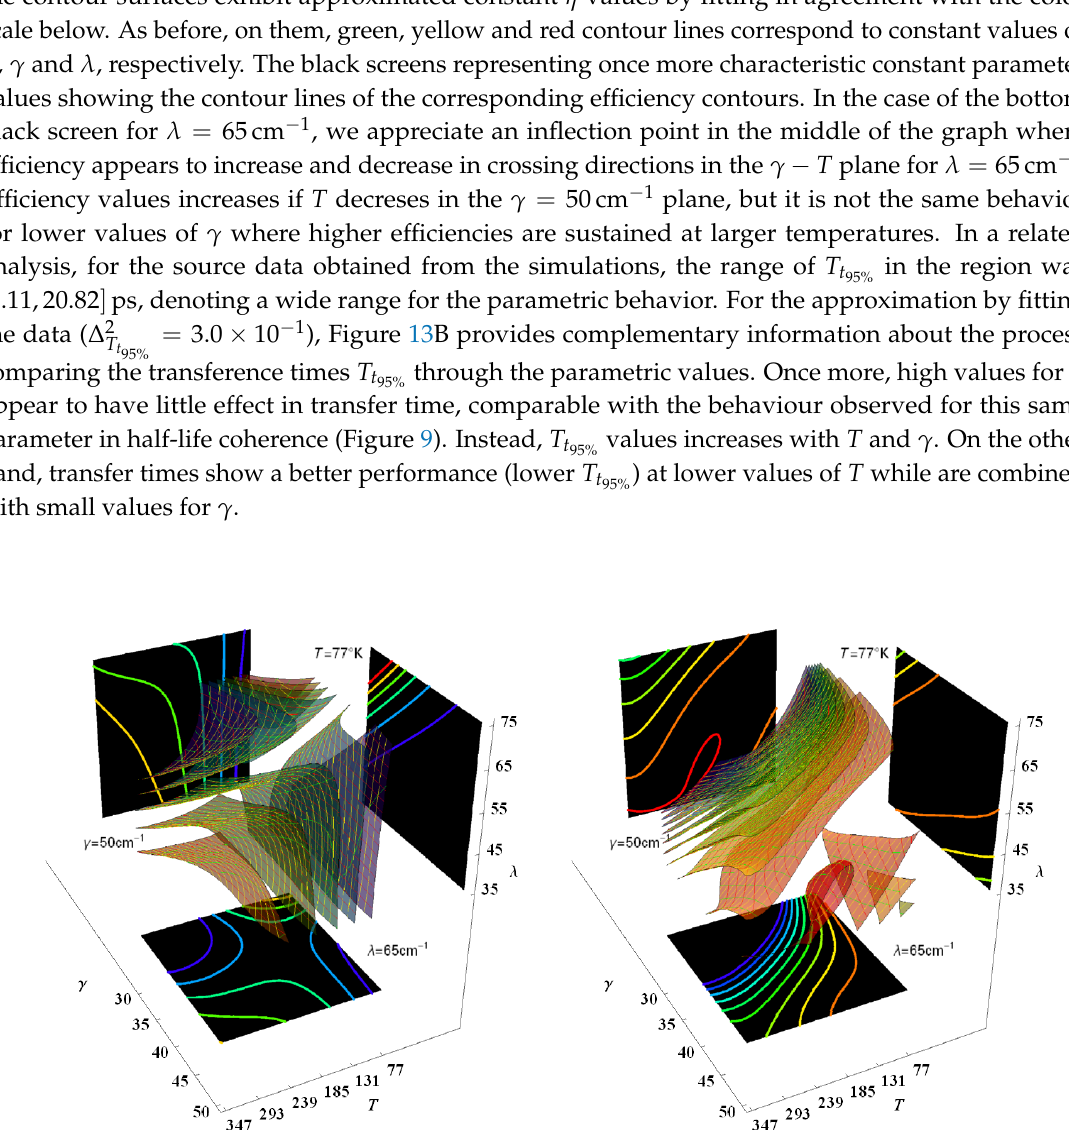
as function of 95%